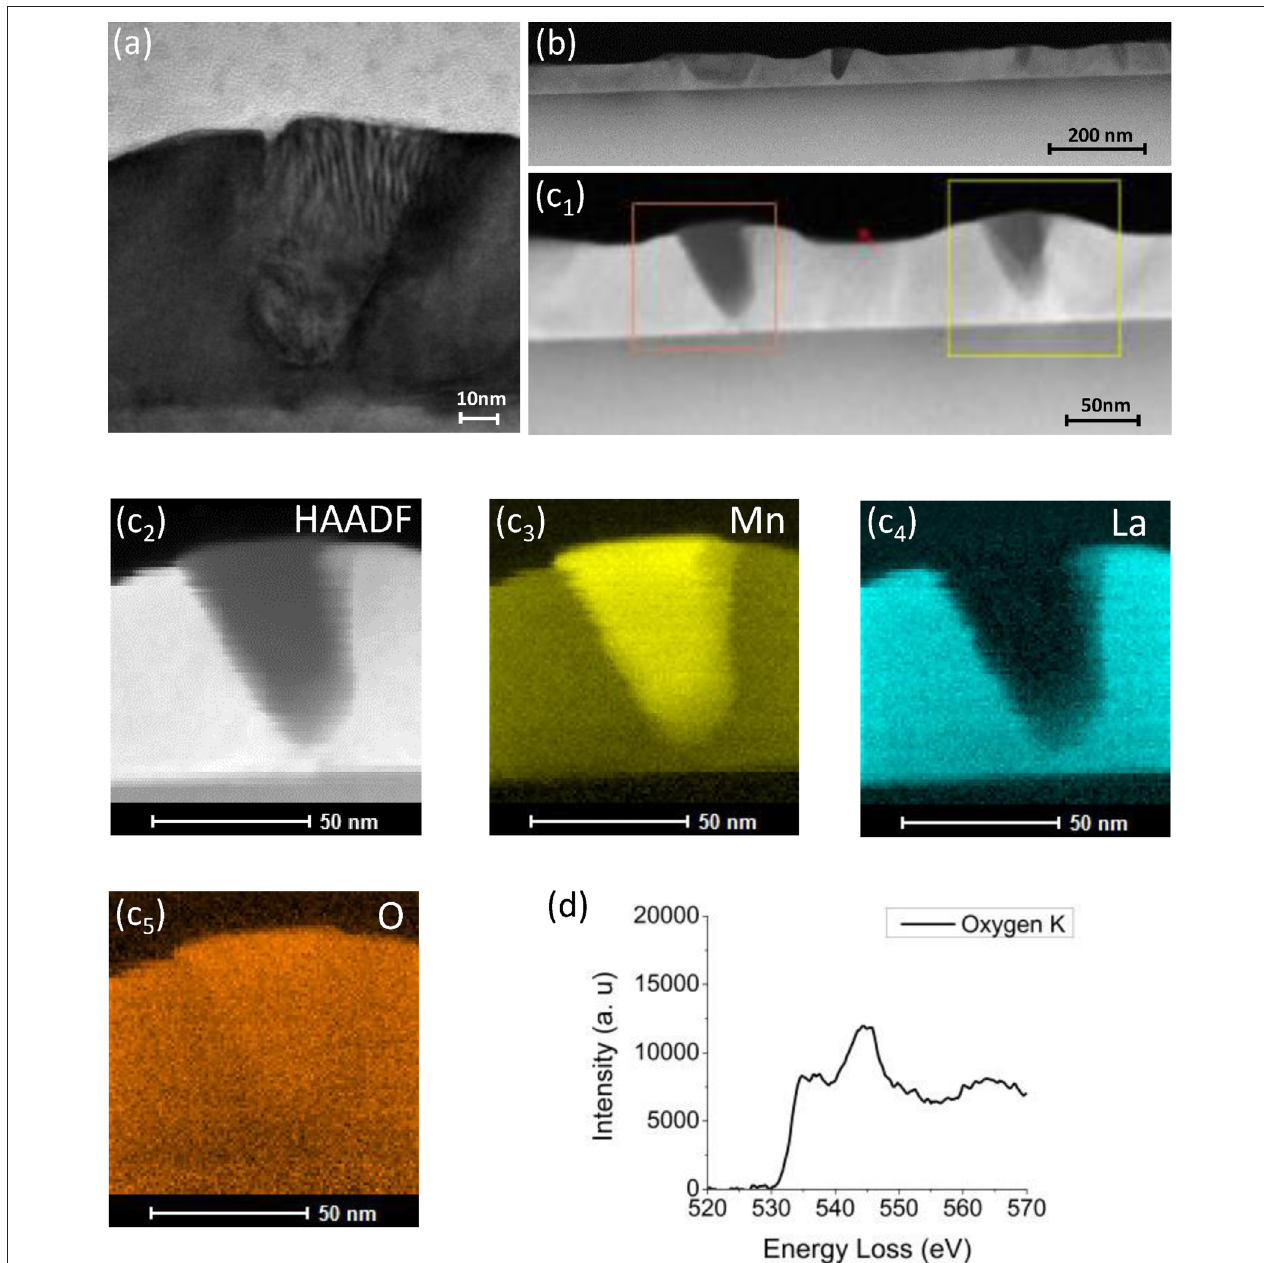
FIGURE 6 | TEM images of 40 nm LMO thick film grown on STO (A) TEM image around a MnOx inclusion (B) HAADF image of the film (C) EELS mapping: (c1) HAADF image where orange square indicate the zone of the mapping and yellow square is drift correction reference, (c2) Z-contrast image used as a reference for the maps: (c3) manganese energy windows, (c4) lanthanum energy windows, and (c5) oxygen energy window. (D) Oxygen K edge EELS corresponding to MnO x nanocolumn obtained from EELS-SI in DualEELS mode.